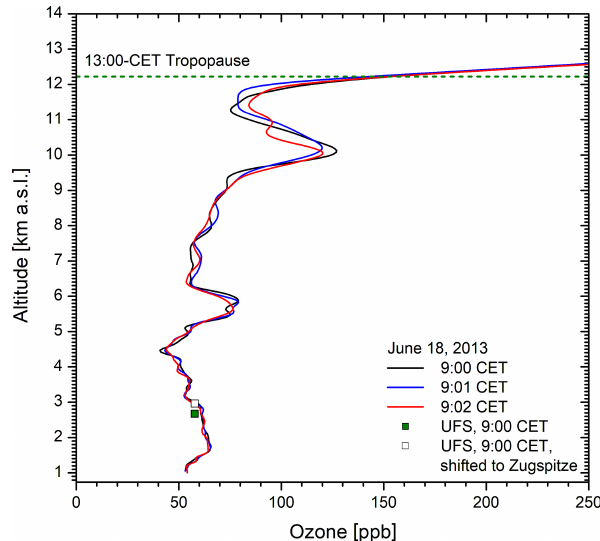
Figure 15. Selection of partial ozone profiles from both receivers of the stationary system: the near-field result can be used here to more than 2km above the lidar due to low ozone density. The ozone hump between about 3.0 and 4.8km is caused by a remote stratospheric air intrusion. The lidar measurement agrees with that at the nearby Schneefernerhaus station (UFS, 2670m; 0.7ppb below blue curve). The altitude of the tropopause is taken from the Munich radiosonde.